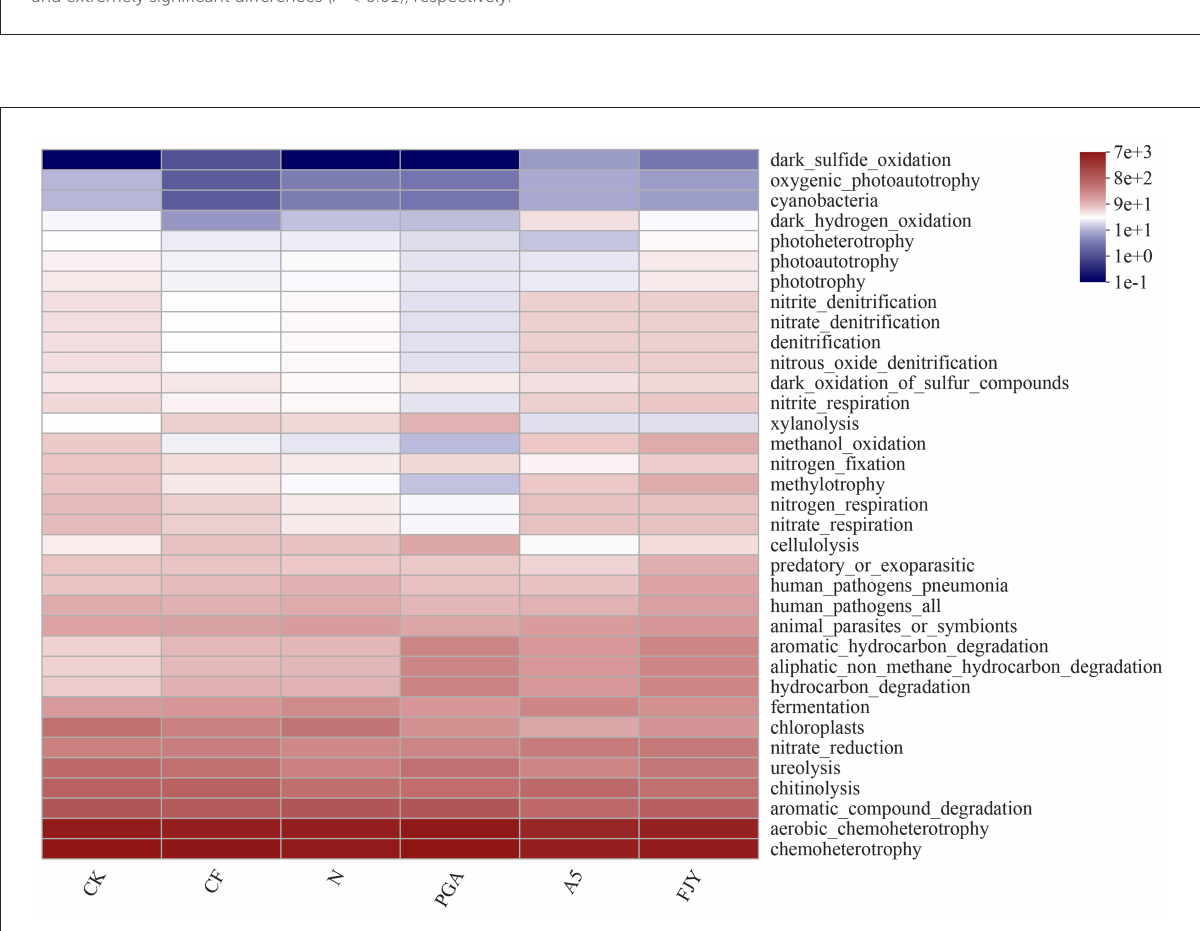
FIGURE5 RDA of rhizosphere soil elements and bacterial community under different fertilization treatments (A) ; Pearson correlation analysis between vegetable yield and quality and bacterial community α diversity in the rhizosphere soil (B) . “*” and “**” indicate significant differences ( P < 0.05) and extremely significant differences ( P < 0.01), respectively.